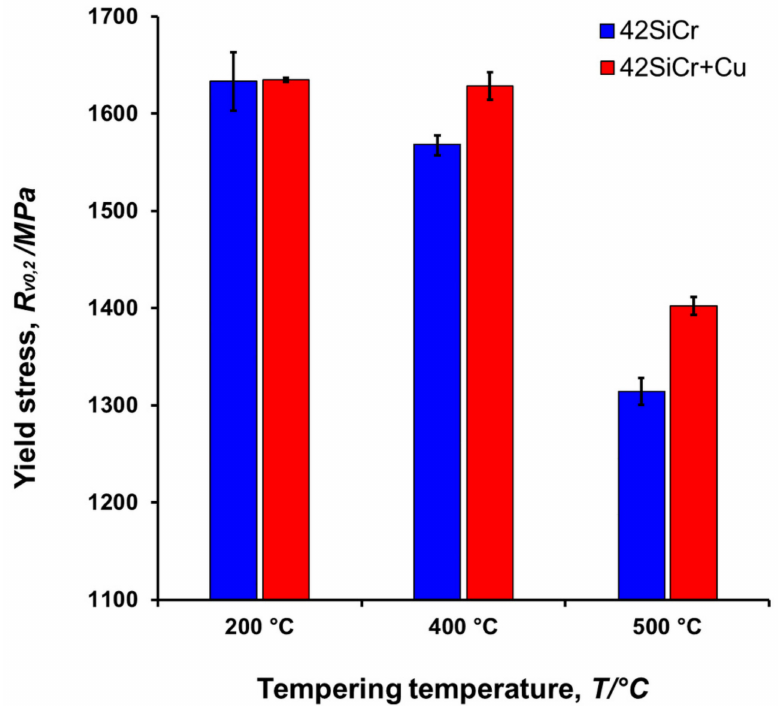
Figure 17. Yield stress R Vp 0,2 of steels 42SiCr and 42SiCr + Cu tempered for two